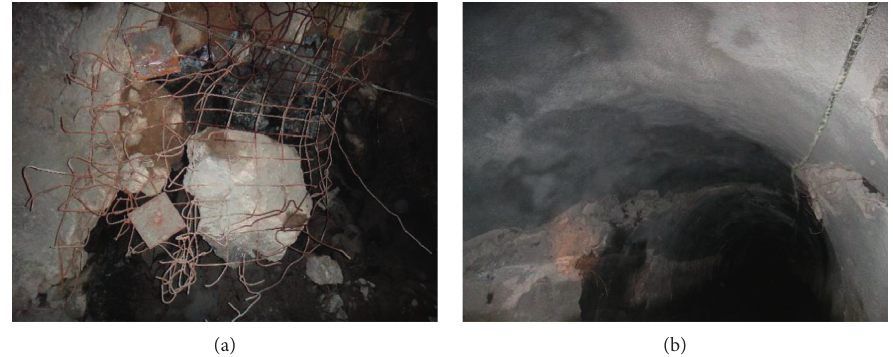
Figure 1: Ground pressure deformation and failure map of Jinchuan No. 2 mining area. (a) Failure of the supporting system. (b) Failure of the roadway.